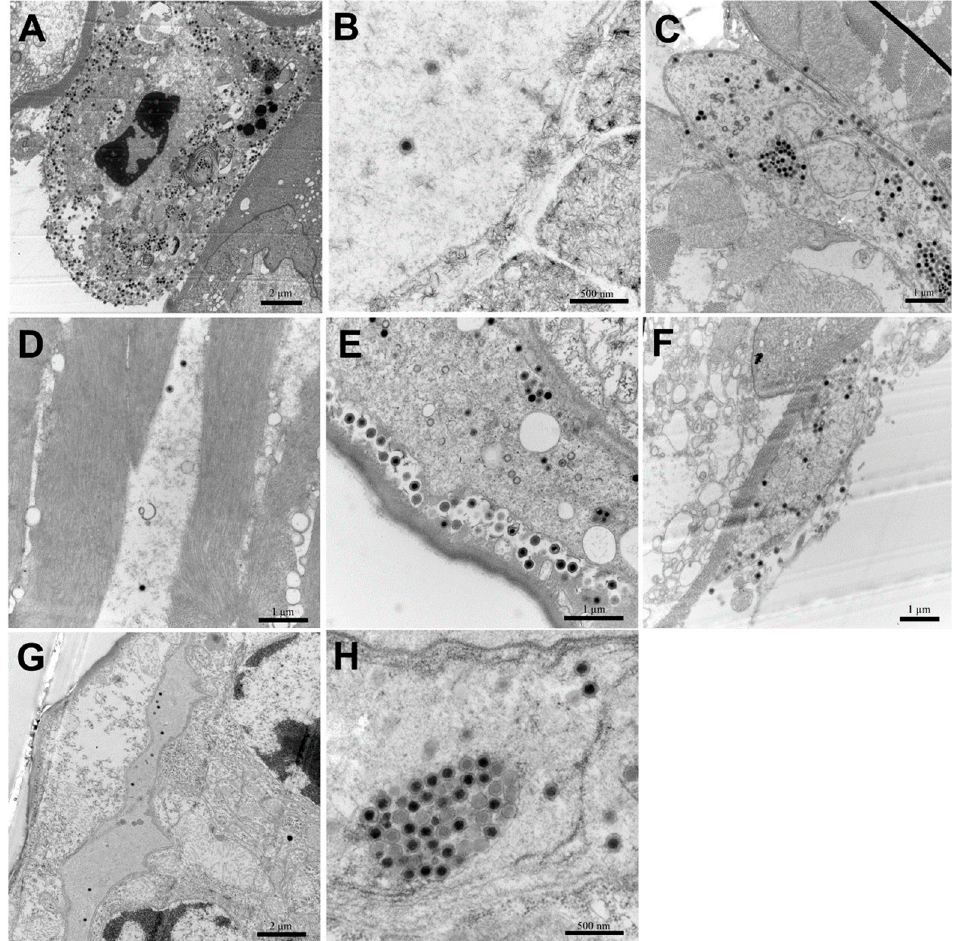
Figure 7. Transmission electron microscopy (TEM) of DIV1-infected Exopalaemon carinicauda . ( A–E ): hepatopancreatic sinus, pereiopods, uropods, muscle and gills, respectively, of a prawn in the IM group; ( F and G ): hepatopancreatic sinus and gills, respectively, of a prawn in the PO group; ( H ): cytoplasmic inclusions with a cluster of viral particles.